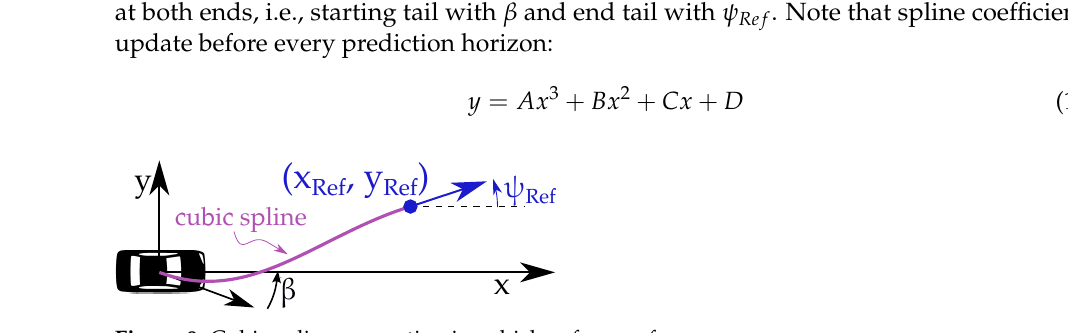
Figure 9. Cubic spline generation in vehicle reference frame.